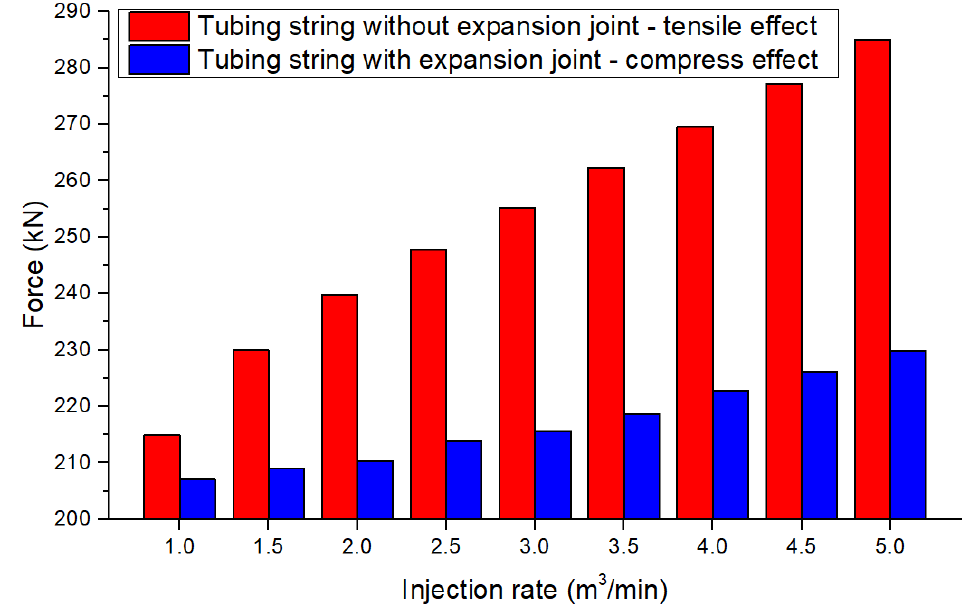
Figure 12. Axial force on the packer from the two kinds of tubing string vs. injection rate.